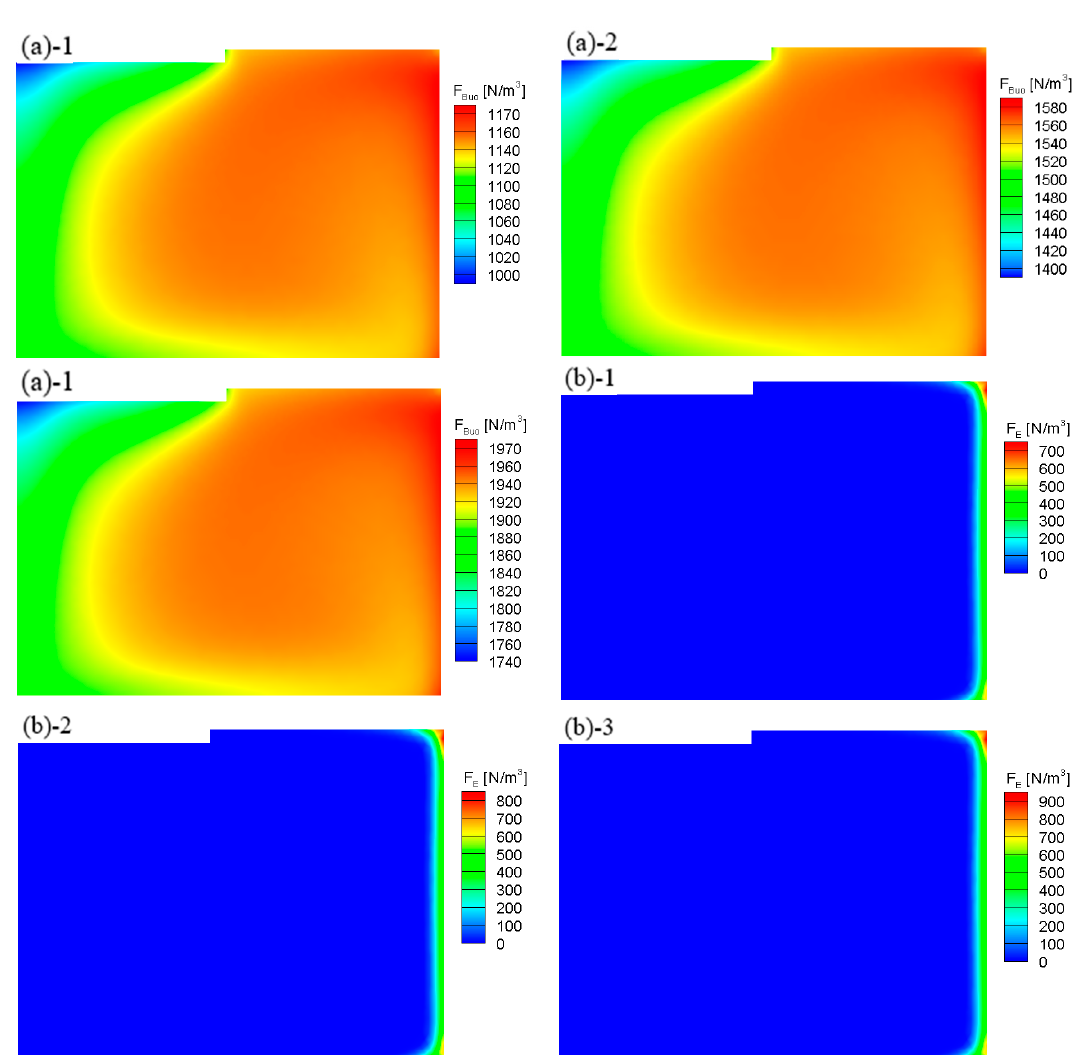
Figure 3. Distribution of the electromagnetic force and thermal buoyancy in solution. ( a ) Thermal buoyancy distribution and ( b ) electromagnetic force distribution; 1, 2 and 3 correspond to the coil currents of 660 A, 700 A, and 740 A, respectively.